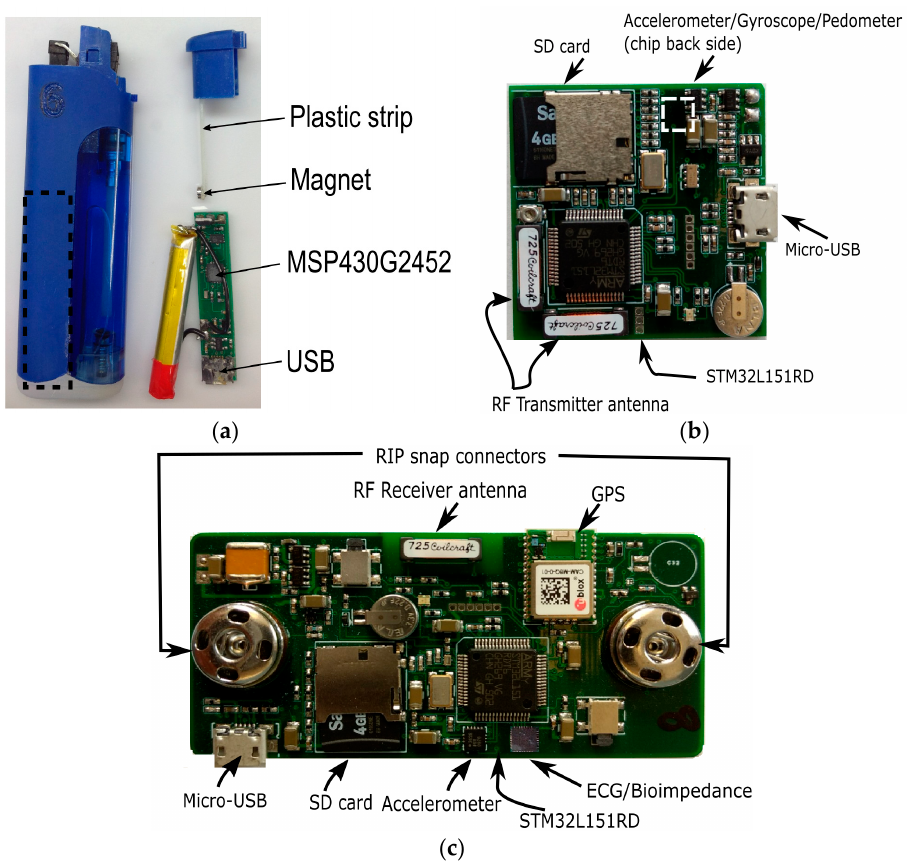
Figure 2. Components for: ( a ) instrumented lighter ( b ) hand module ( c ) chest module. Dashed-line rectangle in the lighter indicates where the board and battery are located inside the lighter.